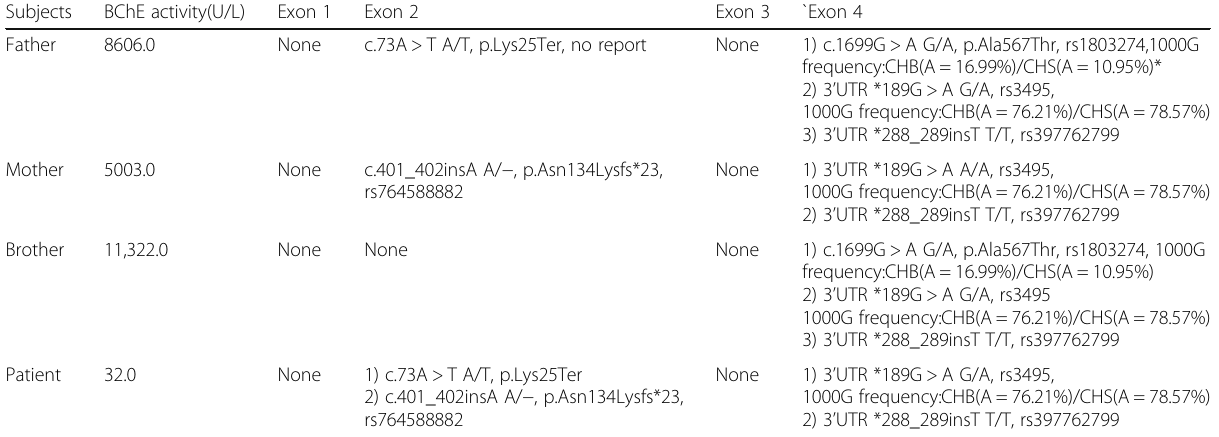
Table 2 BChE activity and genetic variants of BCHE gene identified by Sanger sequencing Subjects